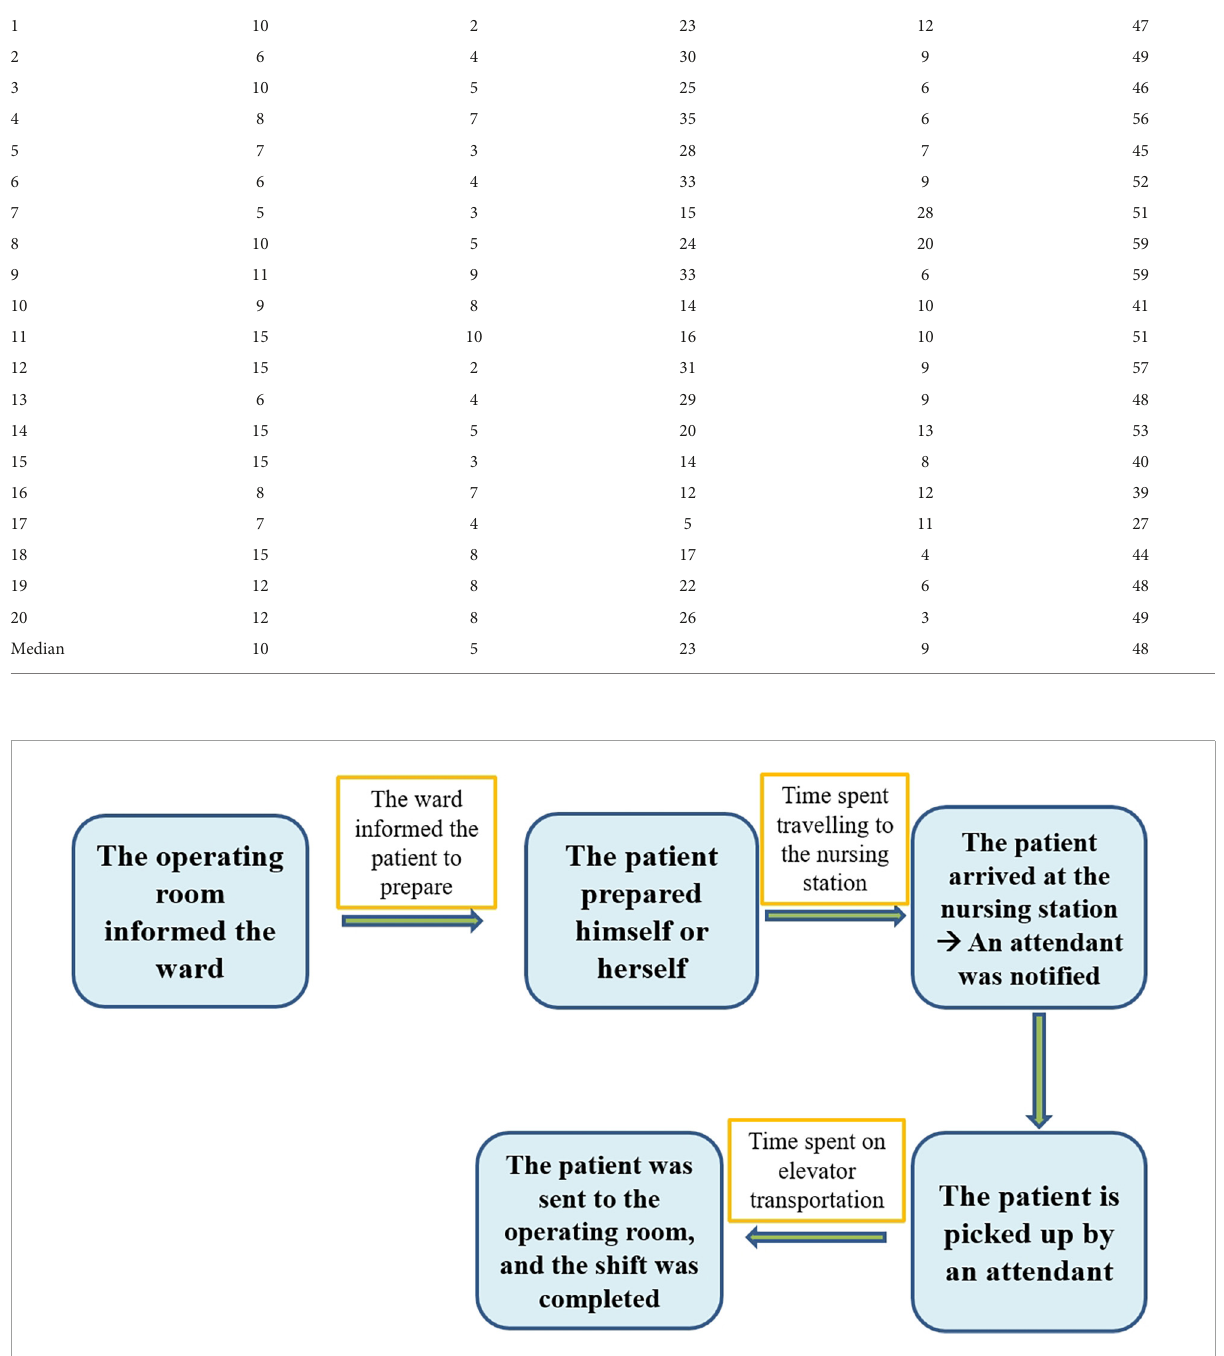
FIGURE2 Value stream map of the existing